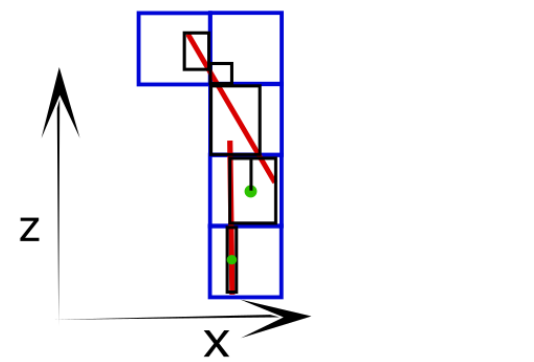
Figure 3. Handling of facade elemets, green line: ground, red line: building, green point: center of the sub bounding box. In case of a neighbour in the vertical direction which includes a facade, the sub bounding box’s center is horizontal inside the current sub bounding box. Such facade including neighbours are excluded of the list of neighbours.